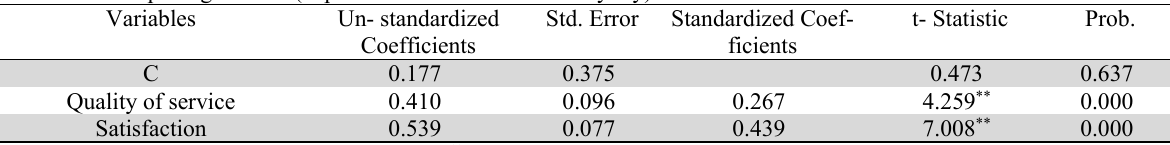
Results of multiple regressions (dependent variable customer loyalty)